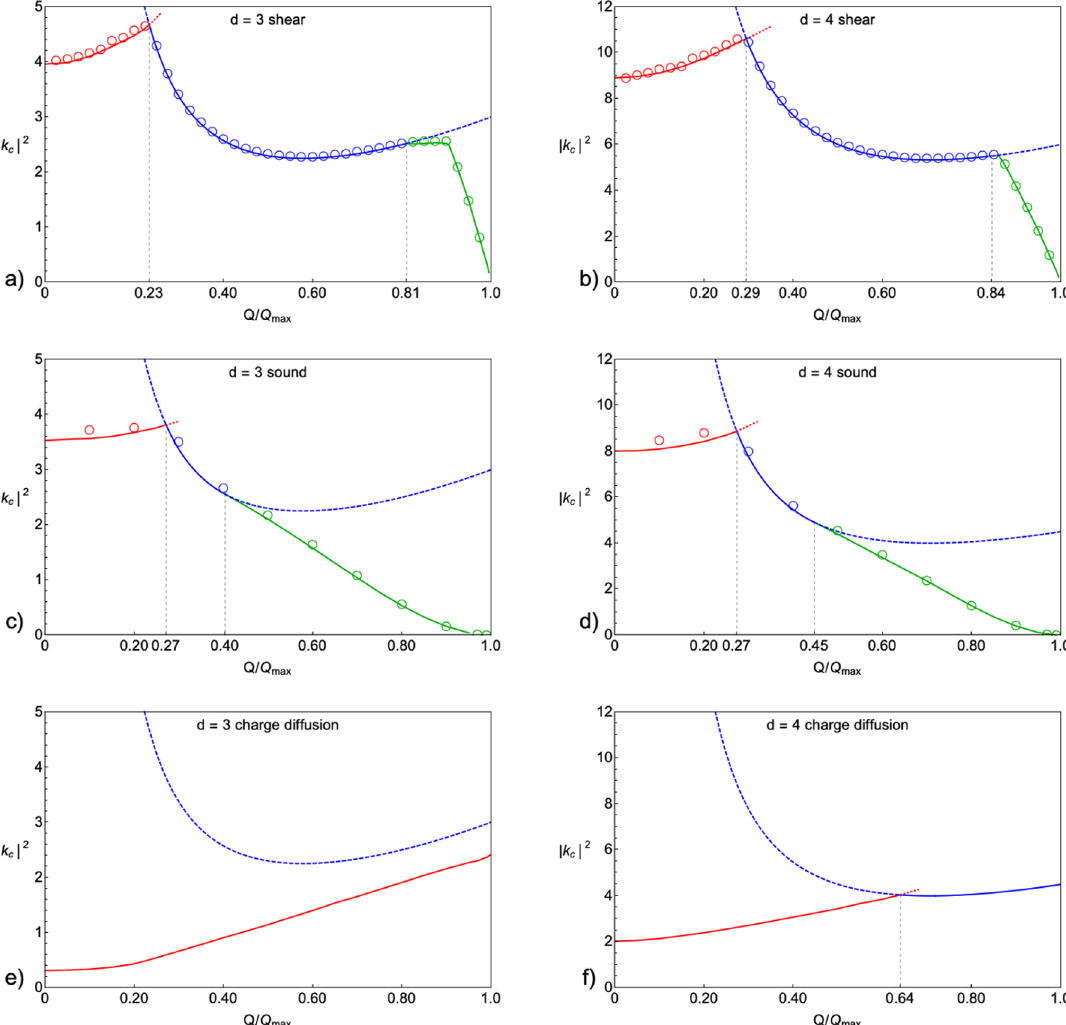
Figure 1 . Radius of convergence as a function of the charge in the system for the hydrodynamic modes in our system, namely shear, sound and charge di(cid:11)usion in d = 3 and d = 4. Each line on these plots corresponds to a di(cid:11)erent branch of pole collisions, with the solid (dashed) lines indicat- ing where each branch is dominant (subdominant). As ~ Q = Q=Q max is varied, di(cid:11)erent branches are responsible for setting the radius of convergence. Transition points are indicated with dashed vertical lines. The circles correspond to the results for the radius of convergence obtained using a perturbative expansion of the corresponding dispersion relations in small momenta up to a very high order, as discussed in section 4. We see that the two methods are in good quantitative